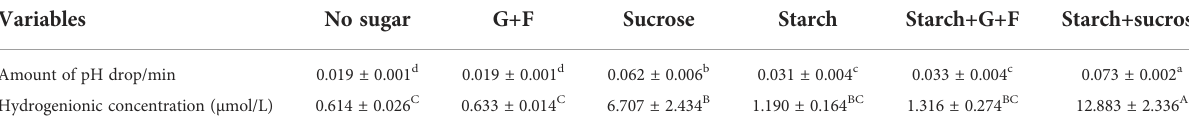
TABLE 1 Acidogenic potential of bio fi lms (means ± standard deviation) over 30 min of fermentation of glucose. Variables